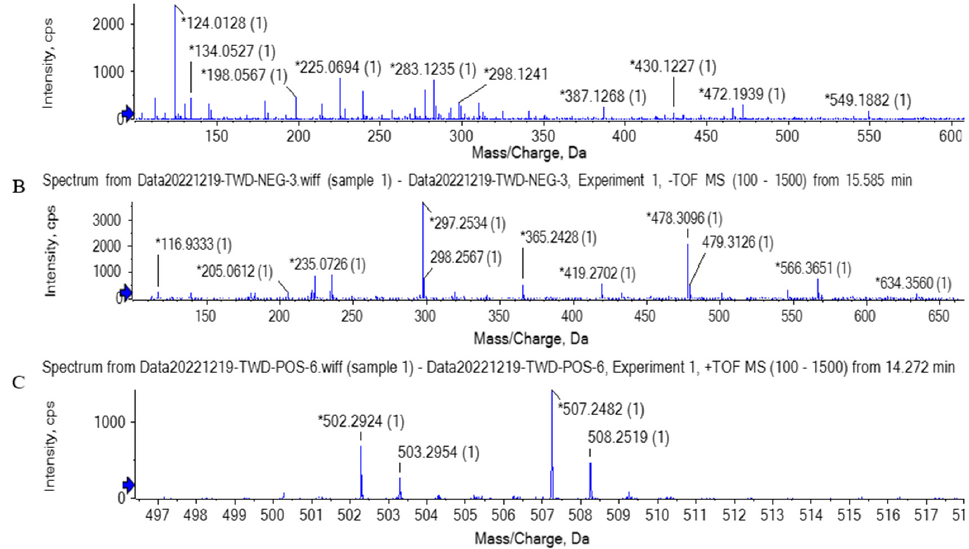
Figure 5. The primary mass spectrogram (MS) of compounds. ( A ) Compound 1 (m/z = 283.12), ( B ) compound 2 (m/z = 365.24), ( C ) compound 3 (m/z = 502.29).